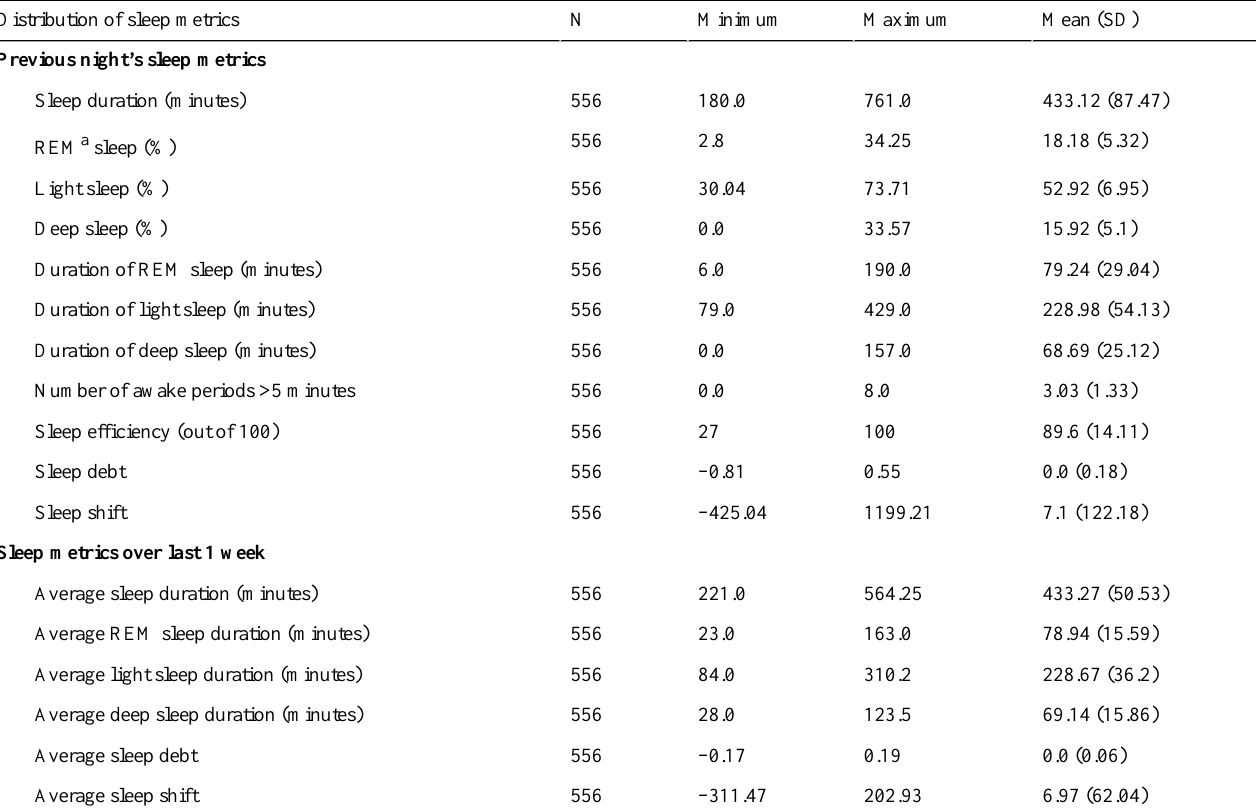
Table 2. Distribution of sleep metrics obtained from the Fitbit as well as weekly averages of the same for all sleep sessions preceding the cognitive tasks.